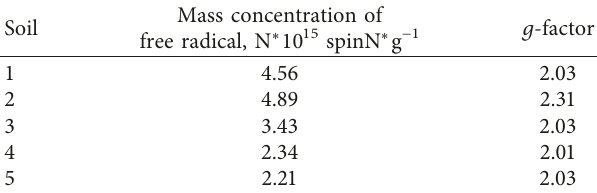
Table 4: Mass concentration of free radical in HAs. Mass concentration of Soil